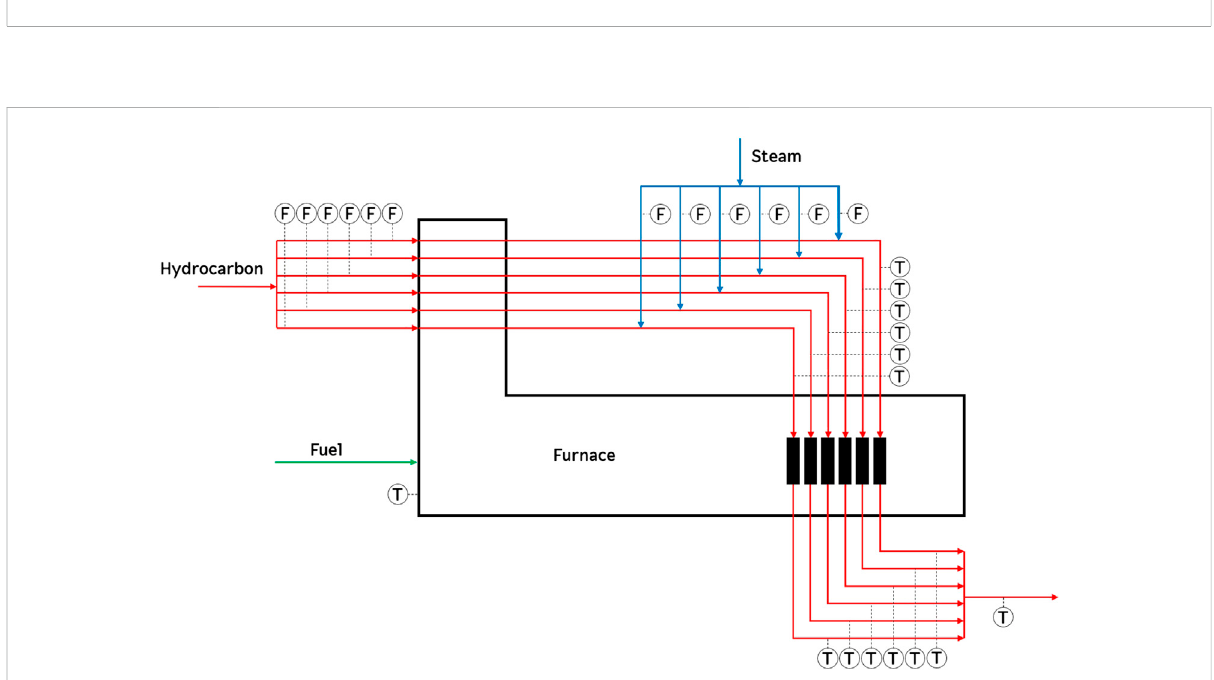
FIGURE 2 Pyrolysis Reactor process